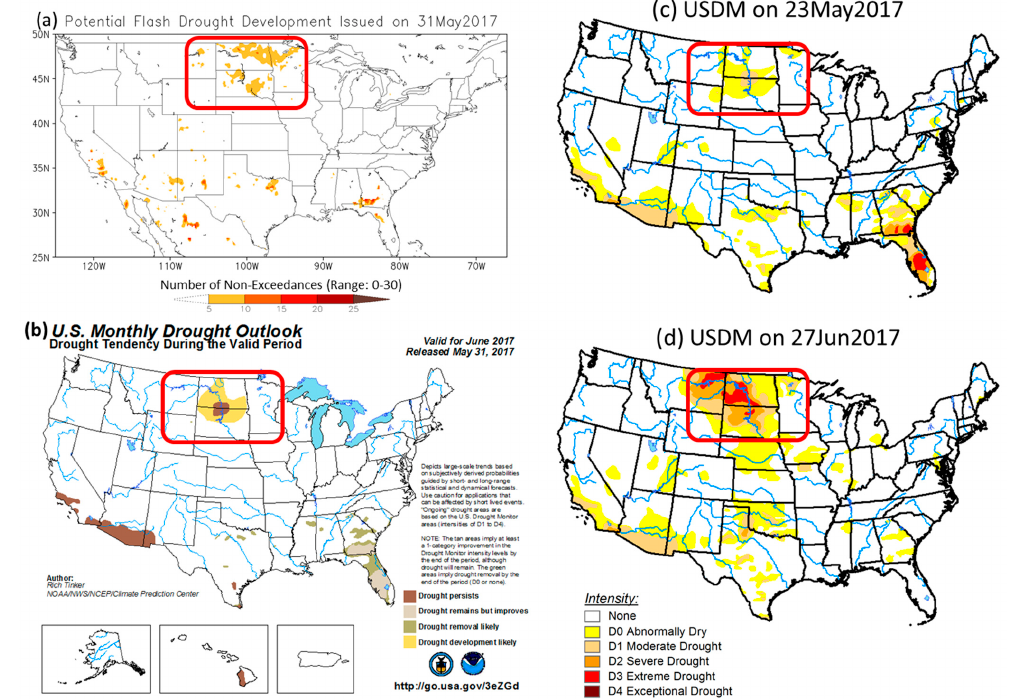
Figure 5. ( a ) Map of potential flash drought development issued on 31 May 2017, ( b ) Monthly Drought Outlook released on 31 May 2017, ( c ) U.S. Drought Monitor valid on 23 May 2017, and ( d ) U.S. Drought Monitor valid on 27 June 2017.